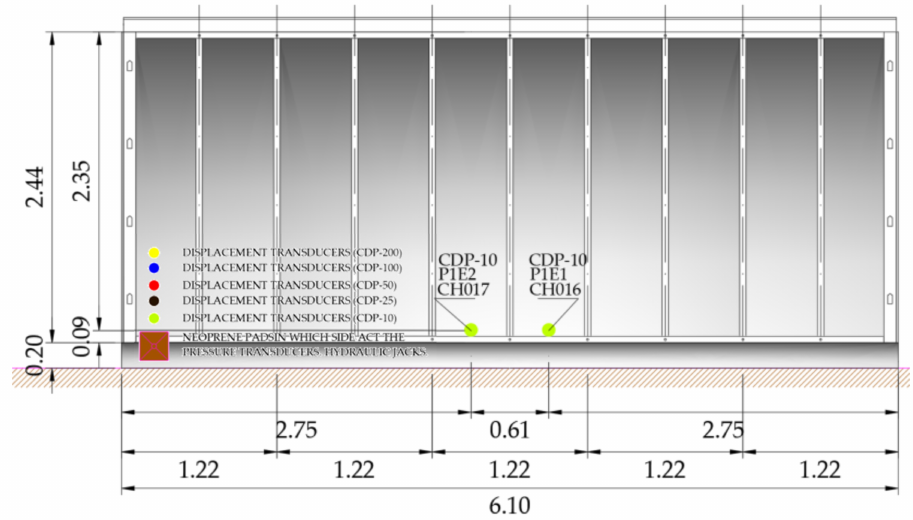
Figure 9. Displacement transducers in anchors to the